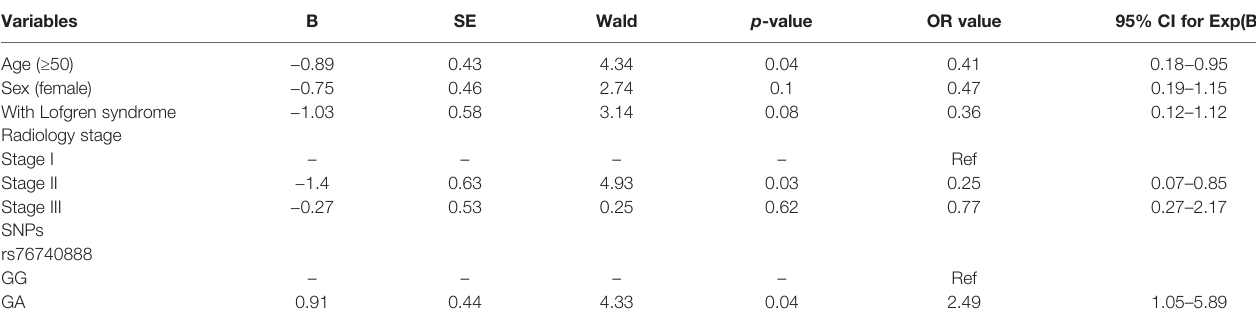
TABLE 4 | Results of logistic regression analysis of risk factors for disease